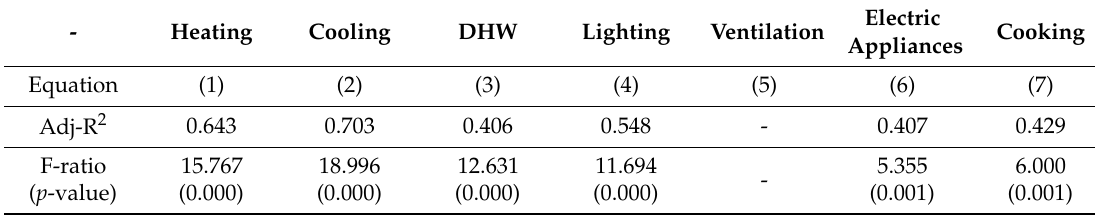
Table 5. Regression analysis results of the estimation